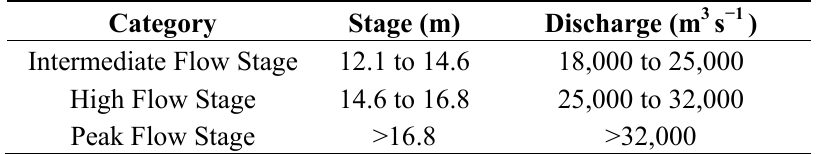
Table 1. Stage category with corresponding river stage at Red River Landing, LA and corresponding discharge at Tarbert Landing,